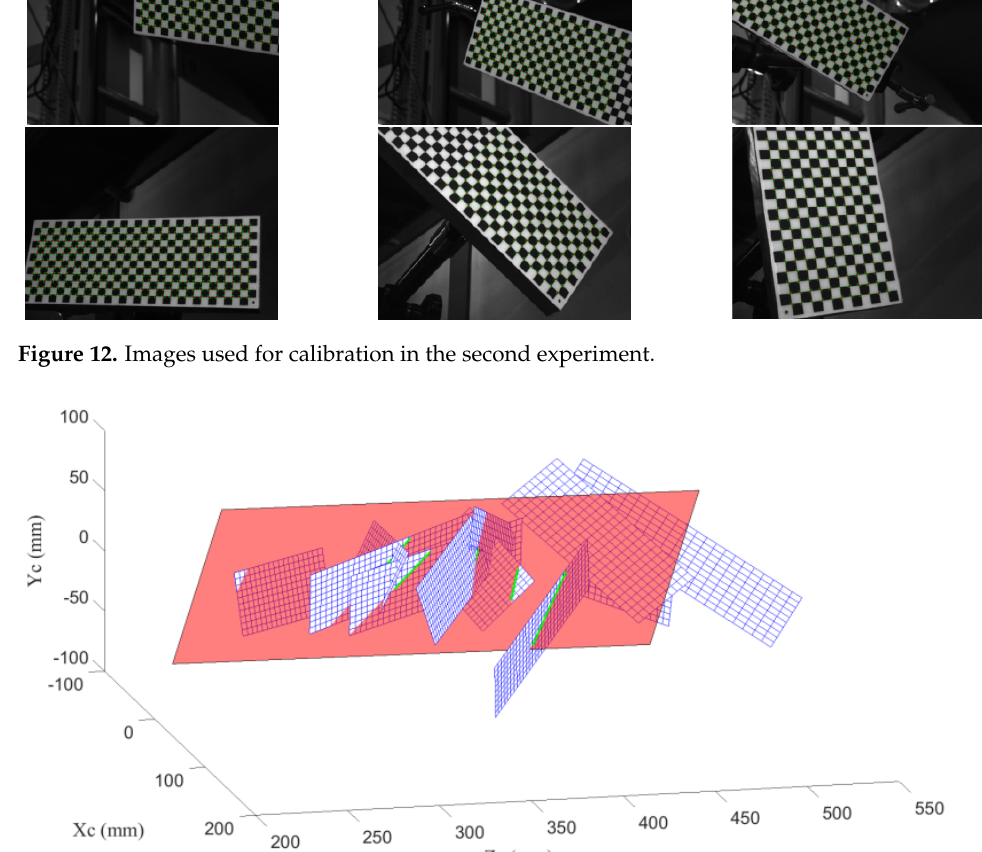
Figure 13. The extrinsic parameters and the fitting laser plane (red) in the second experiment.